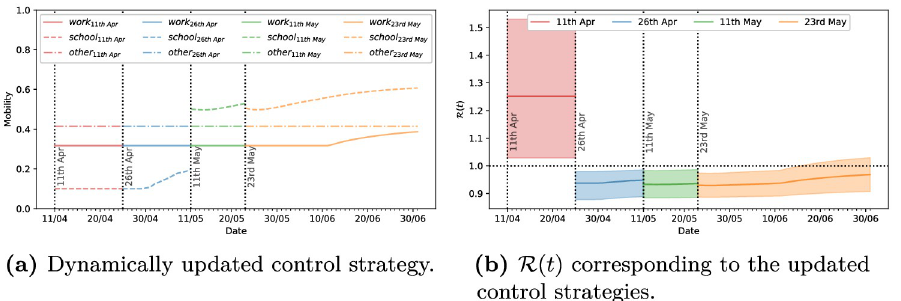
Fig 11. Dynamically updated control strategy: We fit the model on data for England up to t obs = 11th of April and determine the optimal mobility strategy up to the next observation point t used to repeat the procedure, in order to update the optimal control strategy exploiting newly available information. Here ( � , � , � ) = (150, 300, 3). In panel (a), we show the resulting optimal mobility values, with the school work other corresponding values of R ð t Þ and their credibility intervals shown in panel (b).